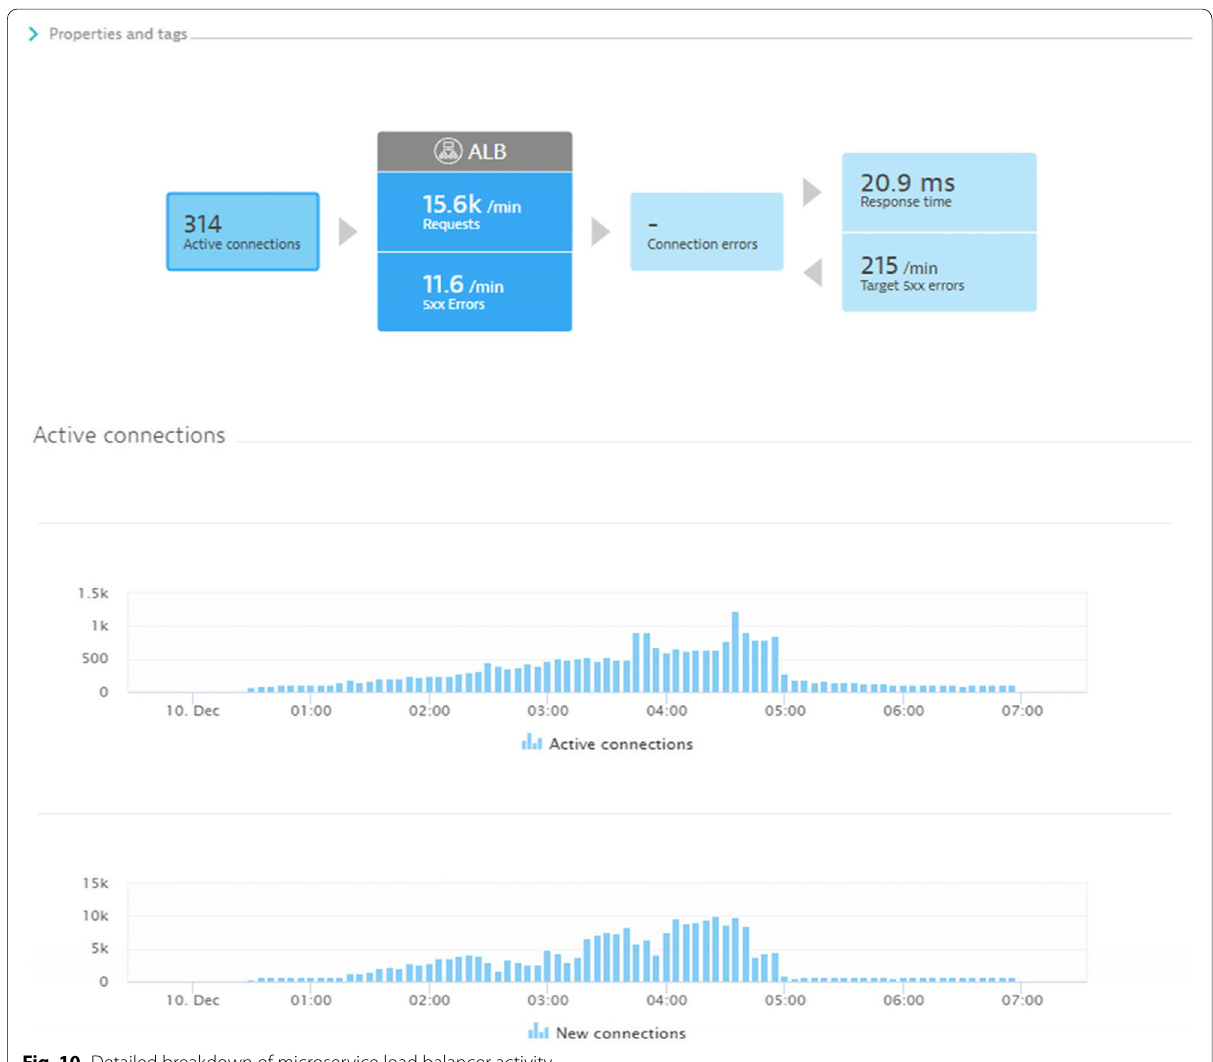
Fig. 10 Detailed breakdown of microservice load balancer activity